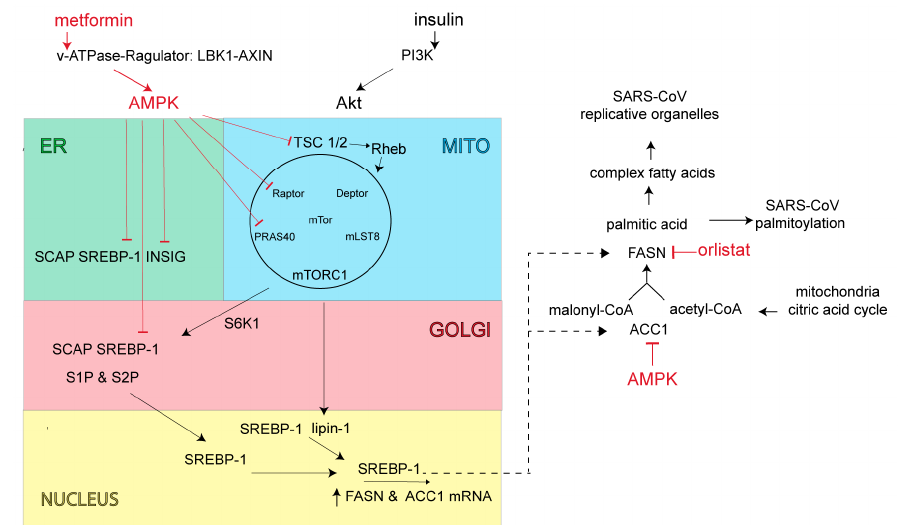
Figure 3. Overview of the lipid synthetic pathway. Insulin activation of mitochondrial (MITO) mTORC1 leads to the phosphorylation of S6K1 and lipin-1. Activated S6K1 acts on ER-resident SREBP-1 resulting in SREBP-1 transport to the Golgi, proteolytic maturation by S1P and S2P, with eventual nuclear entry and transcriptional activation of fatty-acid anabolic genes FASN and ACC1. mTORC1 activation of lipin-1 results in release of perinuclear-bound SREBP-1 for further transcriptional activation of fatty-acid anabolic genes. AMPK blocks fatty acid synthesis by acting directly on the ACC1 enzyme, or indirectly by lowering cellular FASN and ACC1 enzymes through deactivation of mTORC1 or by preventing